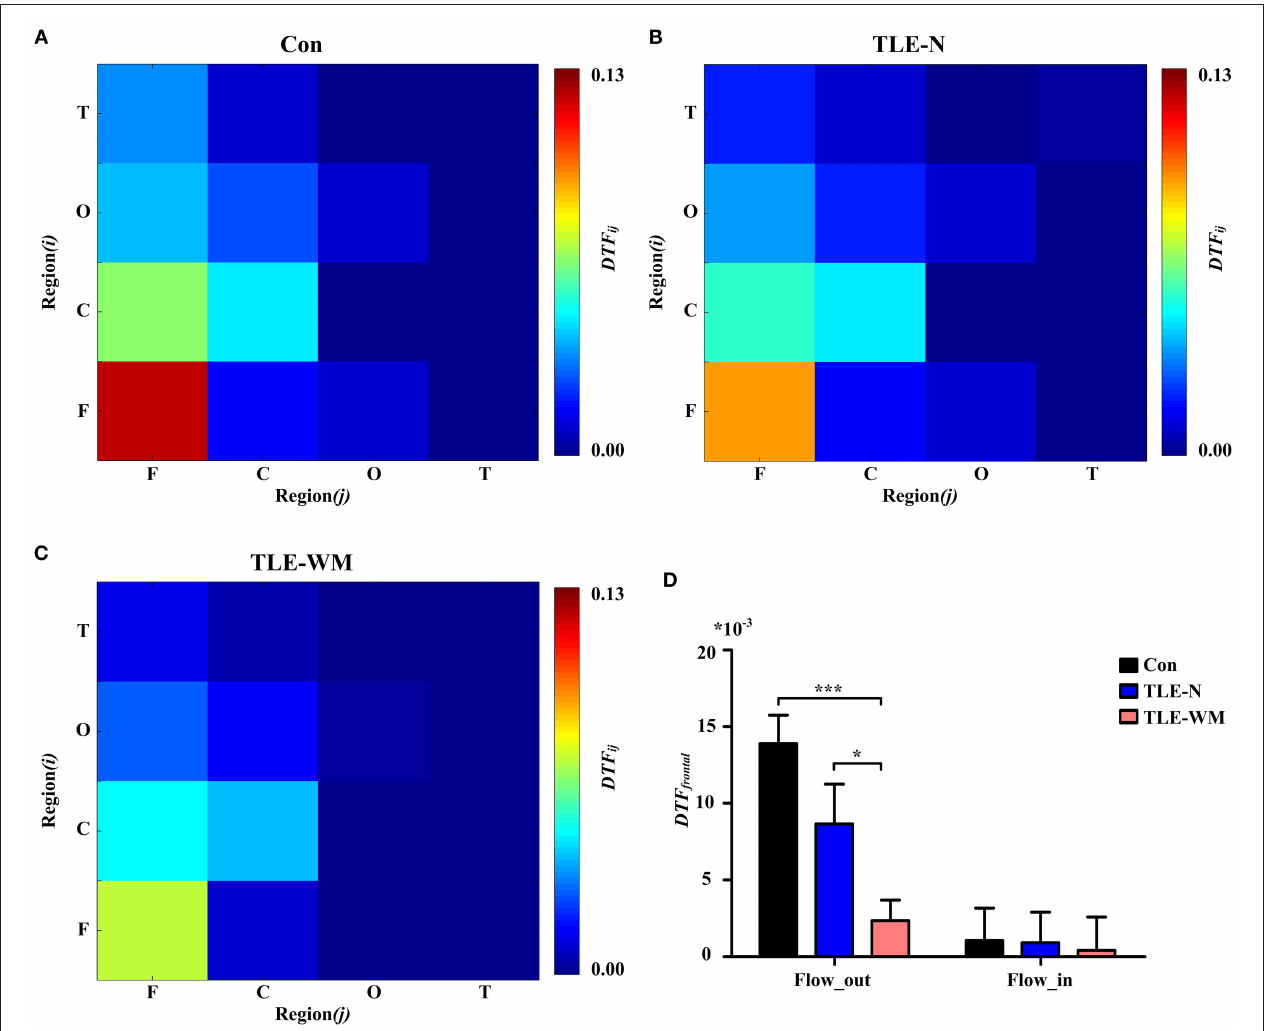
FIGURE 7 | Functional connectivity across brain regions during the WM encoding phase. Connectivity matrices of brain regions in the Con group (A) , TLE-N group (B) , and TLE-WM group (C) . (D) Comparison of the average DTF value of the frontal region among the three groups. * p < 0.05 and *** p < 0.001.